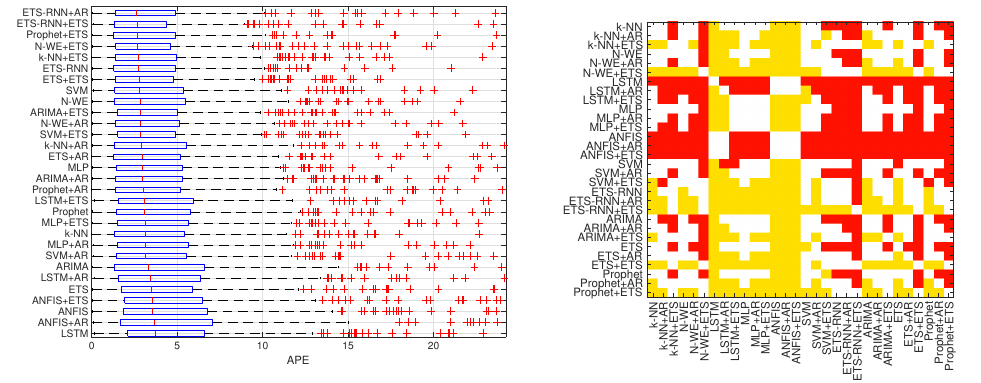
Figure 15. APE and Willcoxon test results for each